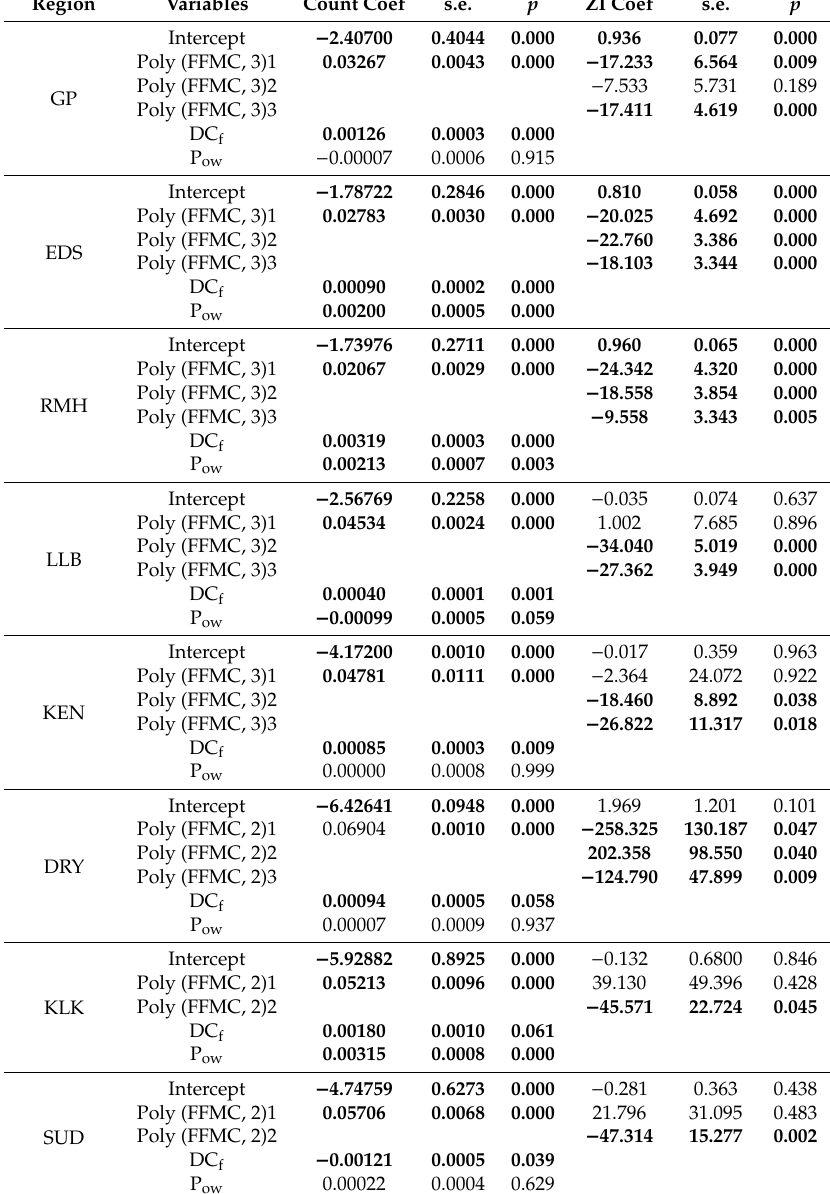
Table 2. Model coe ffi cients (Coef) along corresponding with standard errors (s.e.) and p-values ( p ) for the Zero-Inflated (ZI) Poisson models for all regions. Final models included either quadratic or polynomial terms for the Fine Fuel Moisture Code (FFMC), depending on Akaike’s Information Criterion (AIC) scores and model fit. Results for coe ffi cients with very high to moderate confidence ( p < 0.1) are